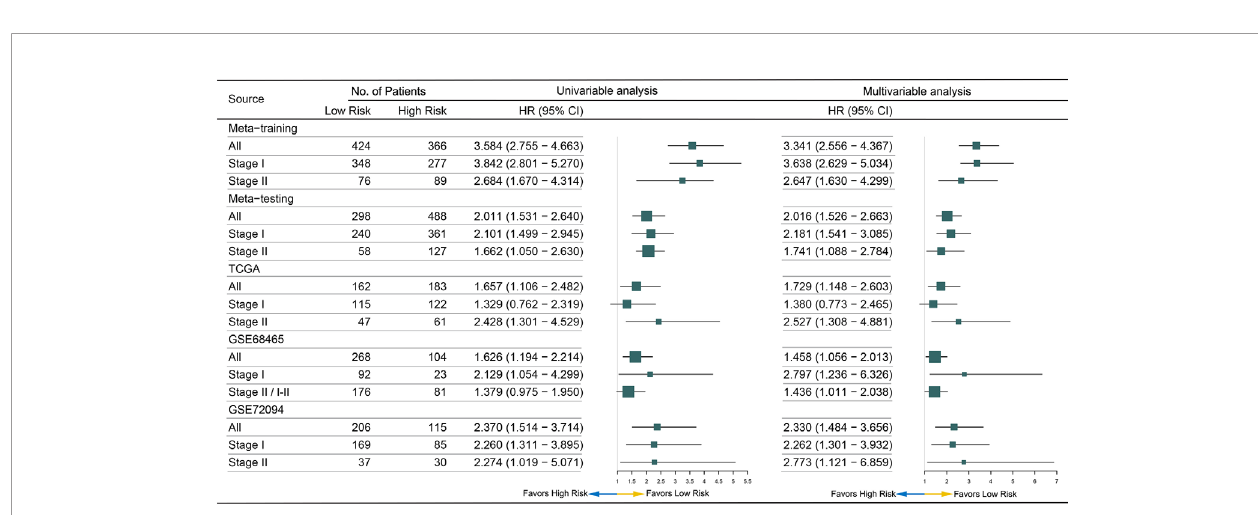
FIGURE 2 | Kaplan – Meier curves of overall survival in the meta-testing (A) , TCGA (B) and GSE68465 (C) and GSE72094 (D) cohort.